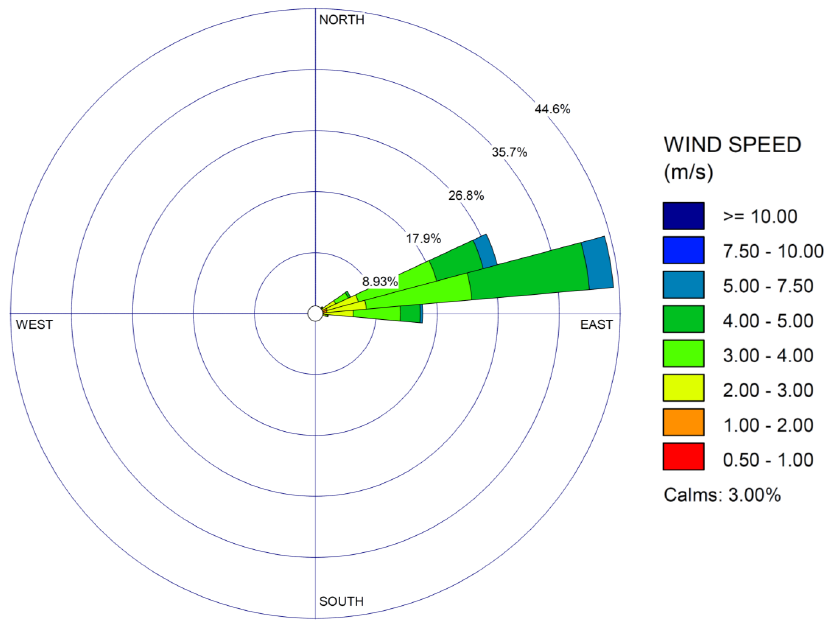
Figure 6. Wind speed distribution per azimuth and scalar category of Palo Verde National Park during the study period. Plot generated with WRPLOT